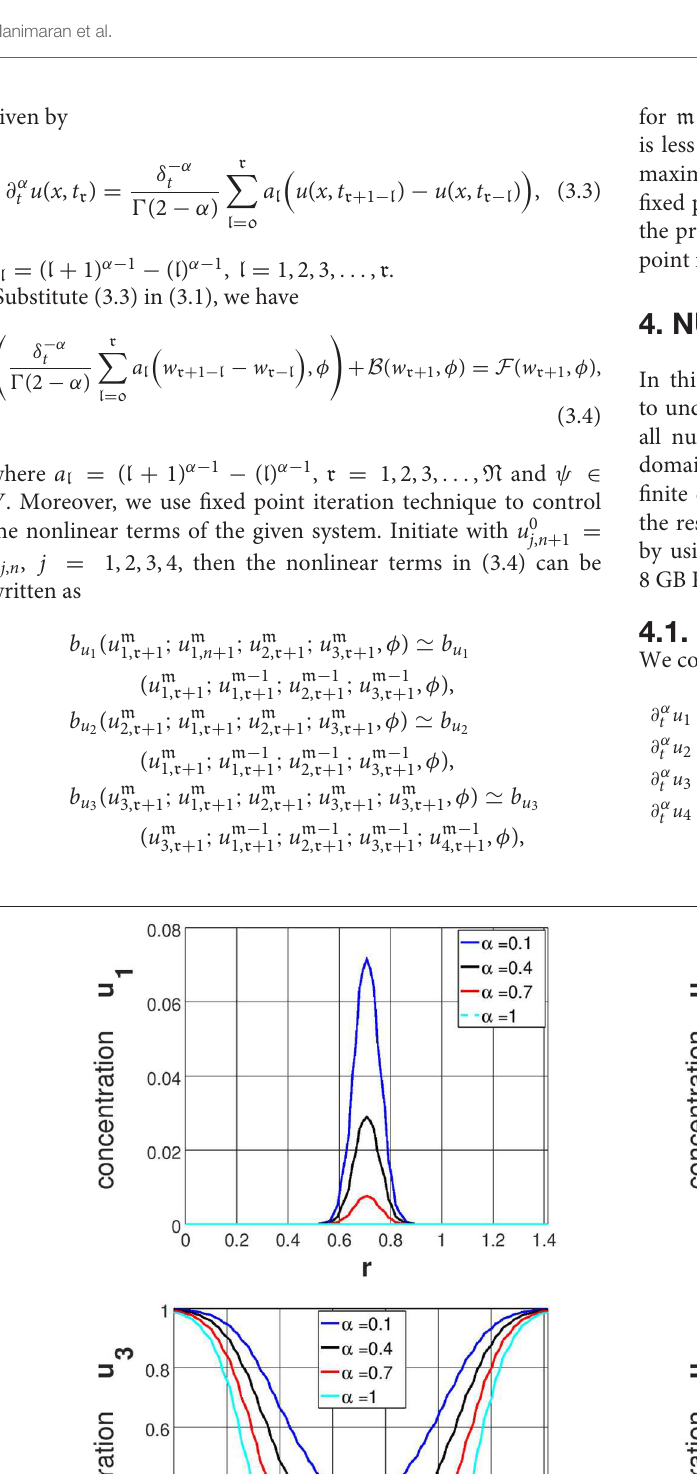
Frontiers in Physics |